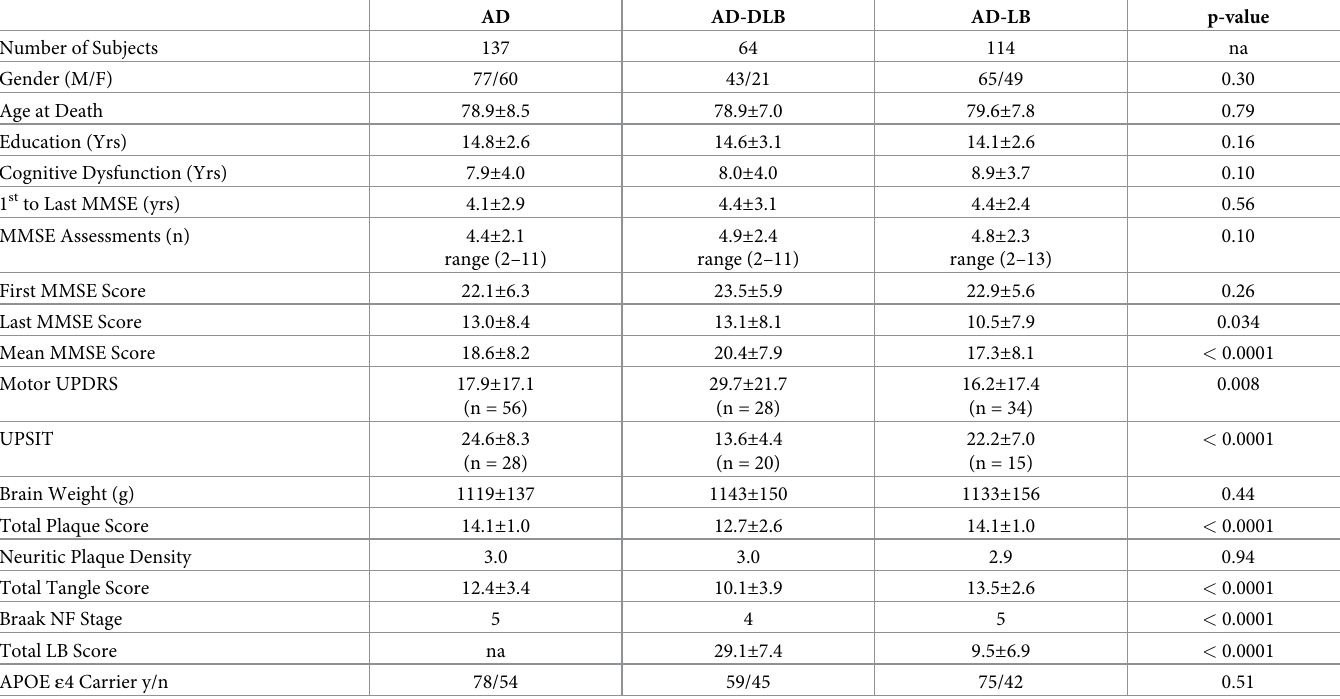
Table 1. Demographic and post-mortem characteristics of study subjects.